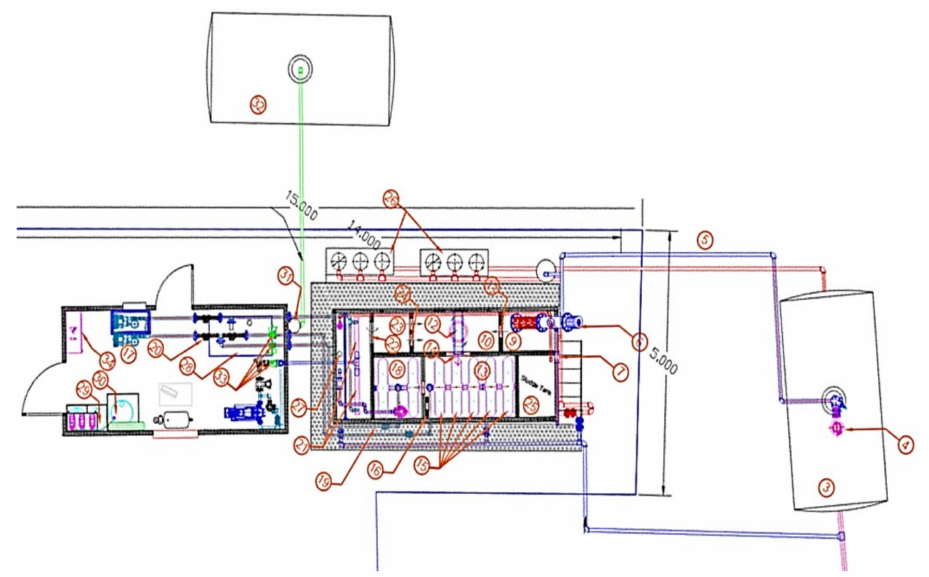
Figure 5. Top view of the hybrid MBR/UV system and the control